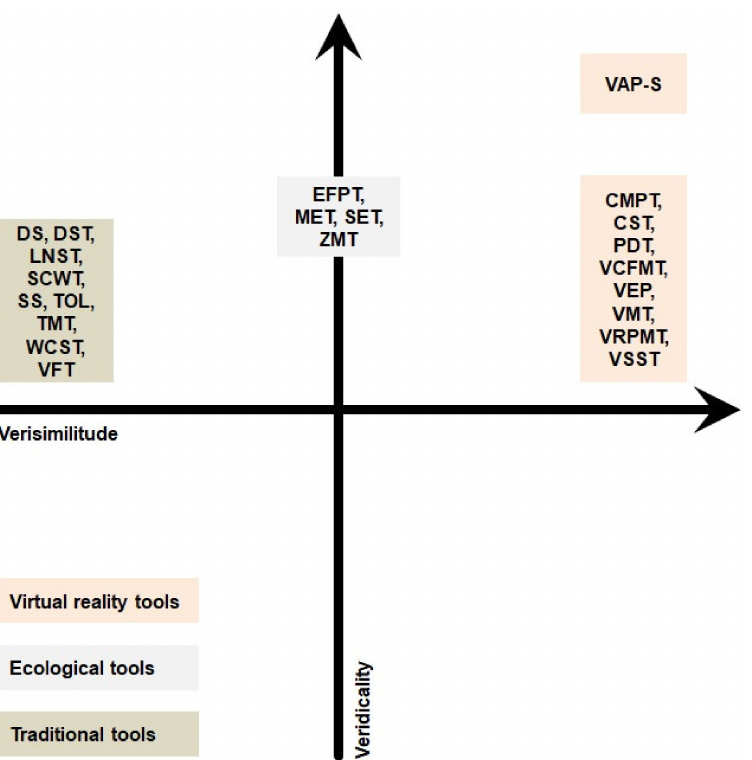
Figure 1. Tools for assessing executive functions in terms of their ecological validity level (verisimil- itude and veridicality). Verisimilitude as a continuous dimension: stimuli and activities without features of real-life—stimuli and activities with features of real-life. Veridicality as a continuous dimension: lack of correlation of functional outcome and behavioral observation—correlation of functional outcome and behavioral observation. CMPT = Computerized Meeting Preparation Task; CST = Computerized Shopping Task; DS = Digit Span; DST = Digit Sequencing Test; EFPT = Ex- ecutive Function Performance Test; LNST = Letter Number Sequencing Test; MET = Multiple Er- rands Test; PDT = Plan-a-Day Test; SCWT = Stroop Color Word Test; SET = Six Elements Test; SS = Spatial Span; TMT = Trail Making Test; TOL = Tower of London; VAP-S = Virtual Action Plan—Supermarket; VCFMT = Virtual Cognitive Flexibility Measurement Task; VEP = Virtual Egyp- tian Pyramids; VFT = Verbal Fluency Test; VMT = Virtual Maze Task; VRPMT = Virtual Reality Prospective Memory Test; VSST = Virtual Supermarket Shopping Task; WCST = Wisconsin Card Sorting Test; ZMT = Zoo Map